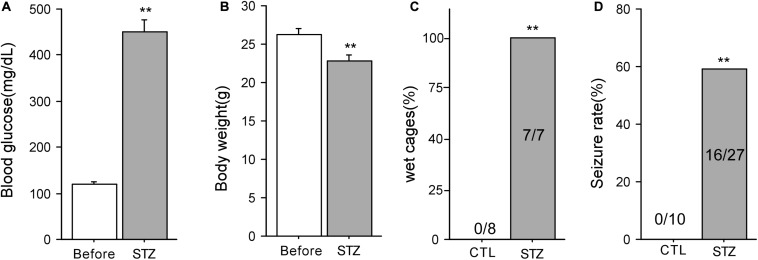
Diabetic animal model in mice and post-ischemic seizures. (A) Blood glucose levels of mice before and 7 days after STZ injection (n = 14). (B) The body weight of mice before and 7 days after STZ injection (n = 19). (C) The percentage of wet cages holding control and diabetic mice. (D) 59% of the mice with diabetes developed seizures following 15-min ischemia, whereas none of the mice with normoglycemia had seizures after ischemia. **P < 0.01 vs. control groups.